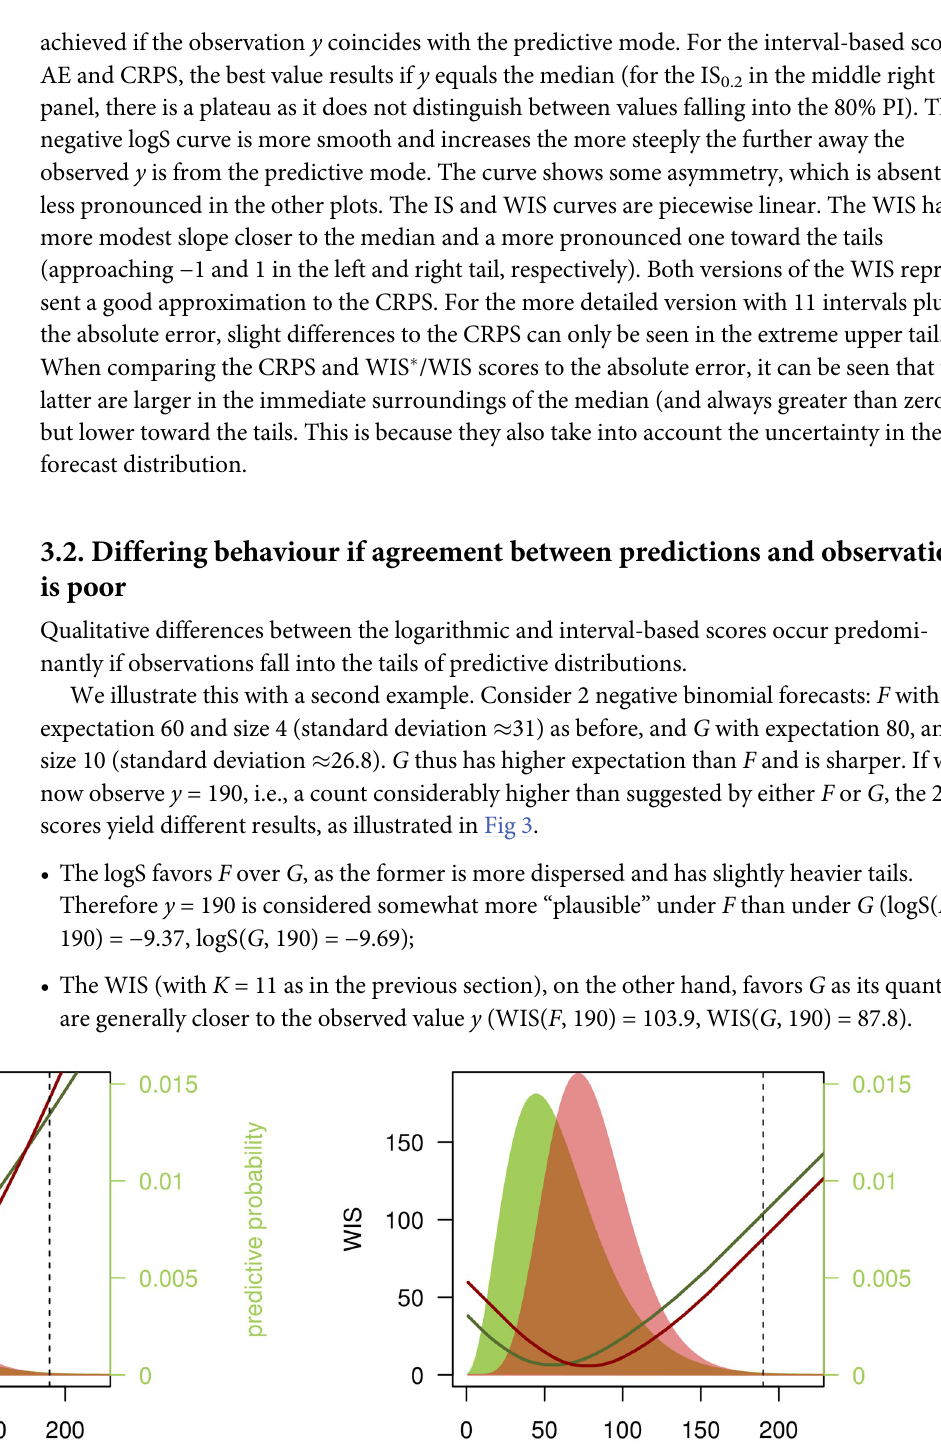
= 60 , μ = 80 and sizes ψ = 4, ψ = 10 . F G F G